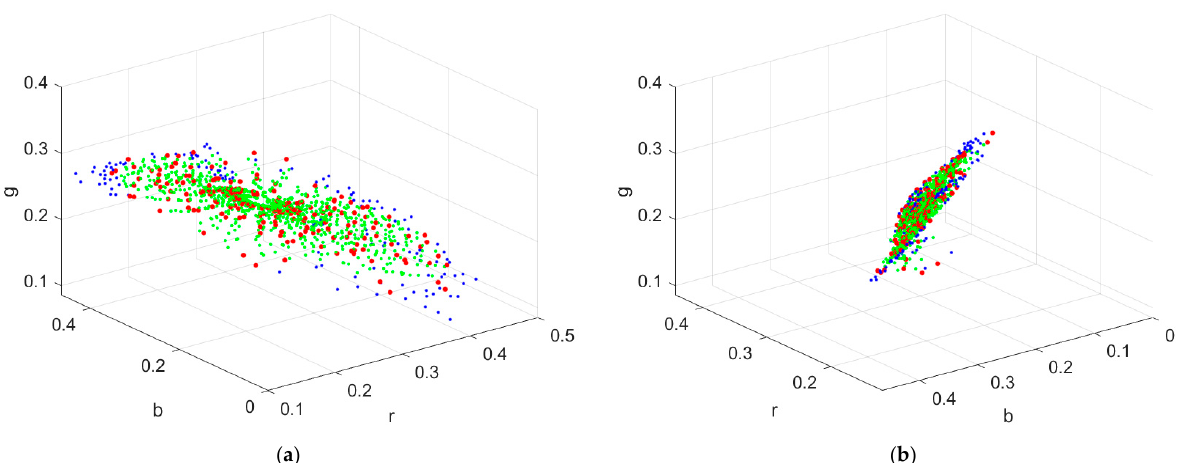
Figure 4. ( a ) Color points of the reference samples, inside samples, and outside samples in the rgb normalized signal space with red, green, and blue dots, respectively, where the camera is the RGBF camera. ( b ) The same as ( a ) except for viewing angle.